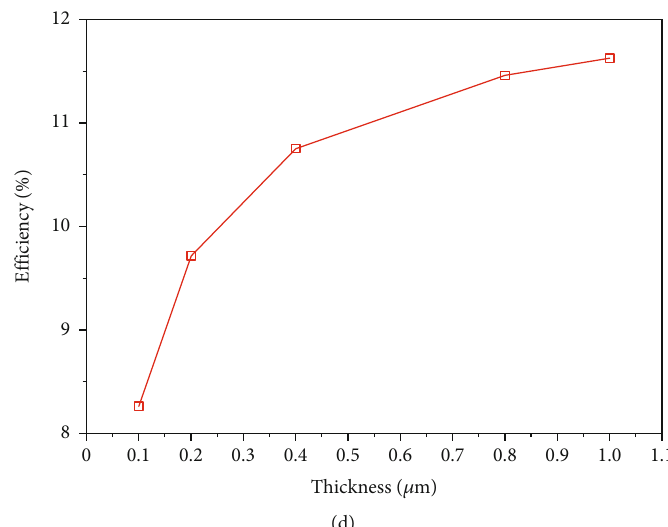
η SC , (b) V OC , (c) FF, and (d)